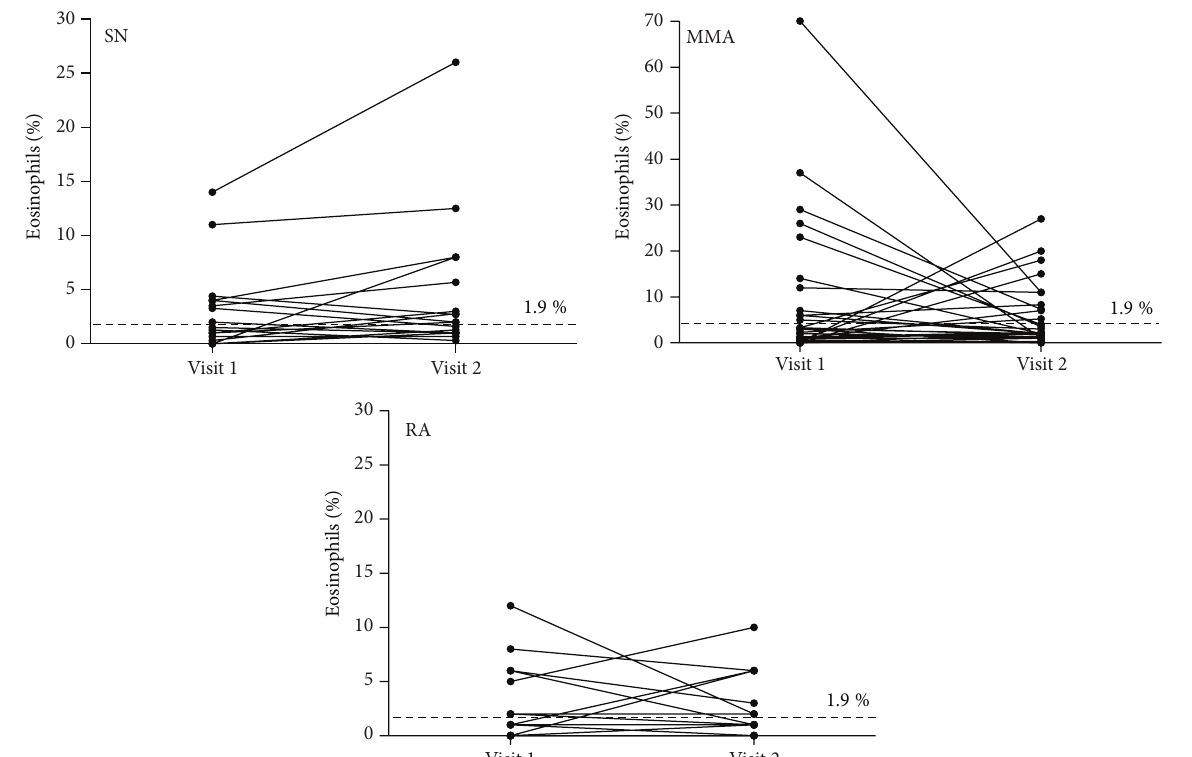
Figure 2: Changes in sputum eosinophils count in studied asthma cohorts: steroid-na¨ıve asthma (SN), mild to moderate asthma (MMA), and refractory asthma